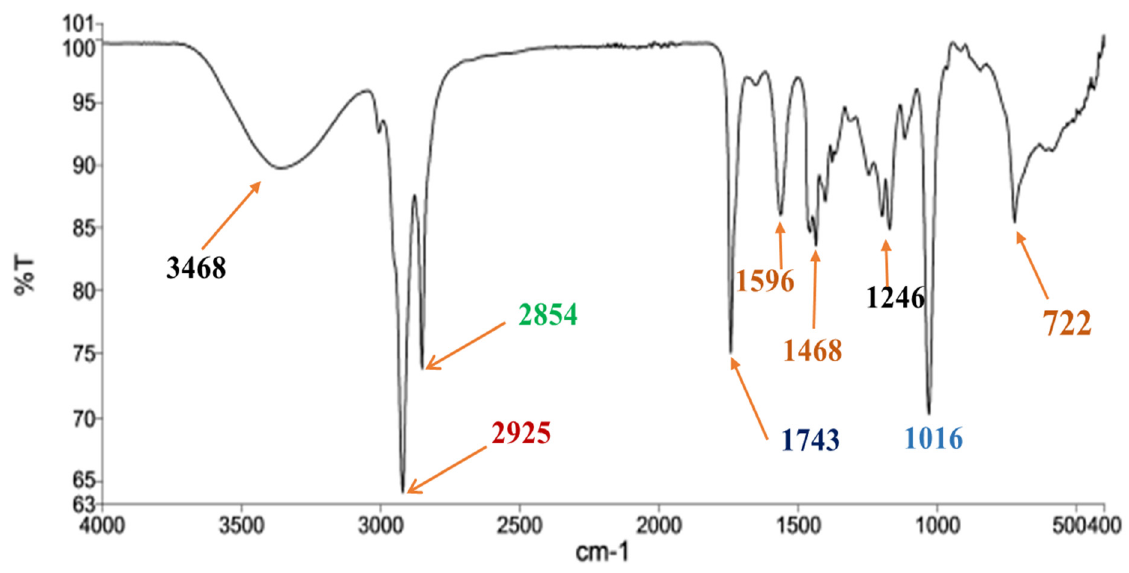
Figure 5. FTIR spectrum of Kapok biodiesel.